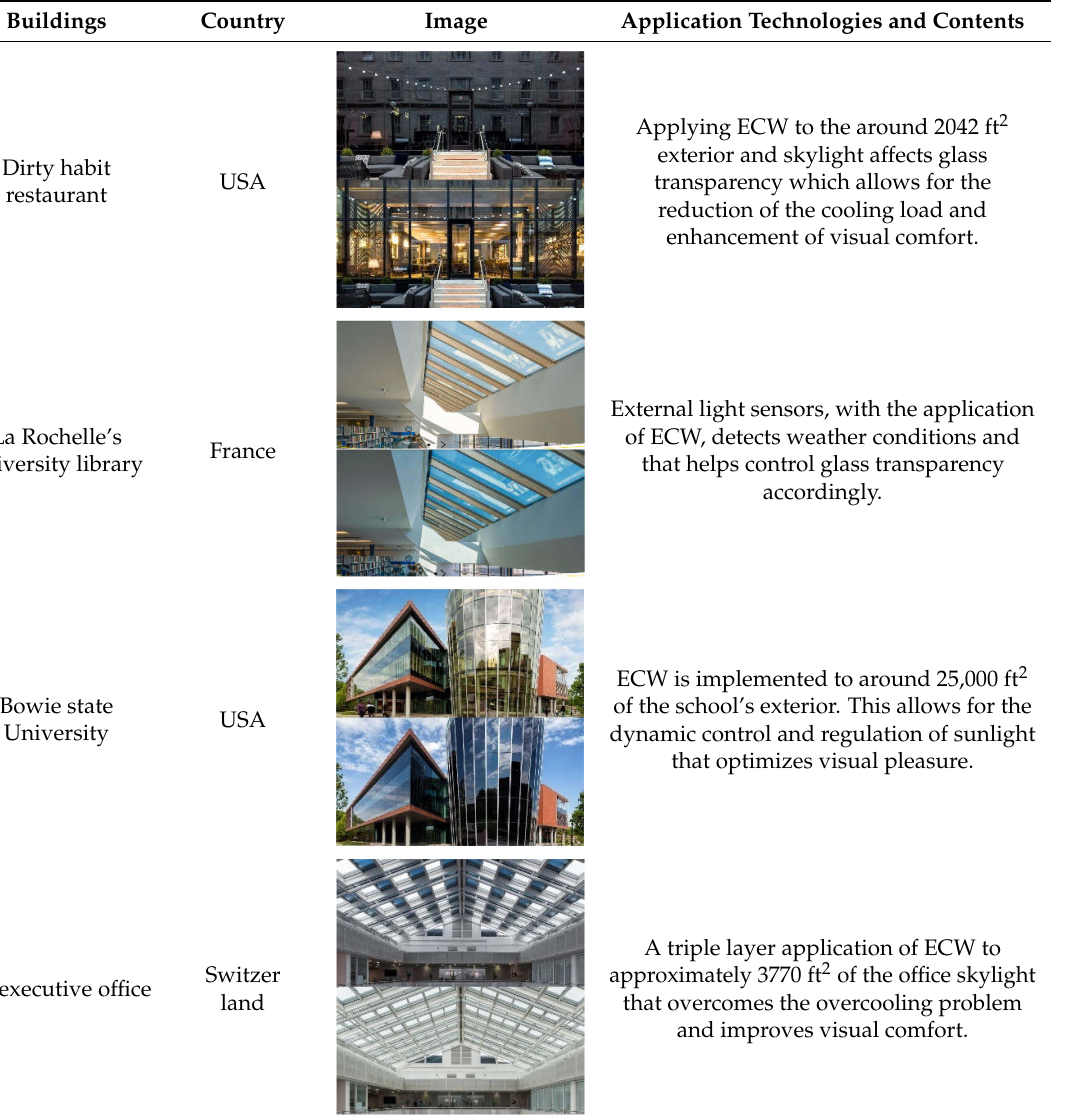
Table 1. Case study of electrochromic window (ECW)